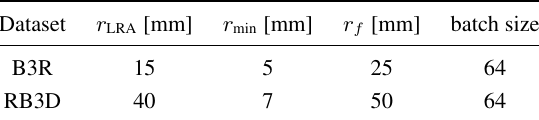
Table 1. Parameters used for computation of the feature descriptor in the experiments presented herein.